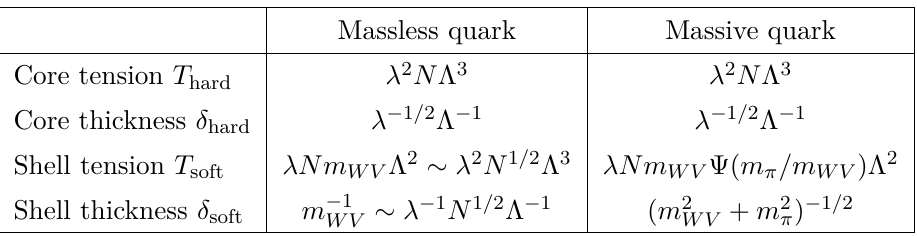
Table 1 . Summary of parametric dependence of tension and thickness of the core and shell parts of the sheet. For the reader’s convenience, we used the dynamical scale notation Λ instead of M